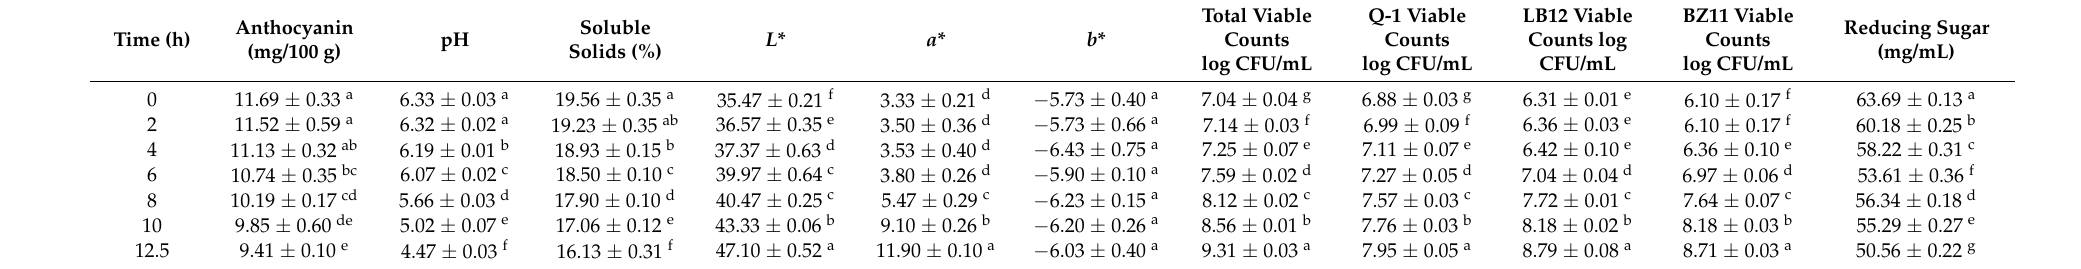
Note: a–g means within the same column without a common superscript are significantly different ( p < 0.05). Table 8. Correlation analysis of physical and chemical changes during